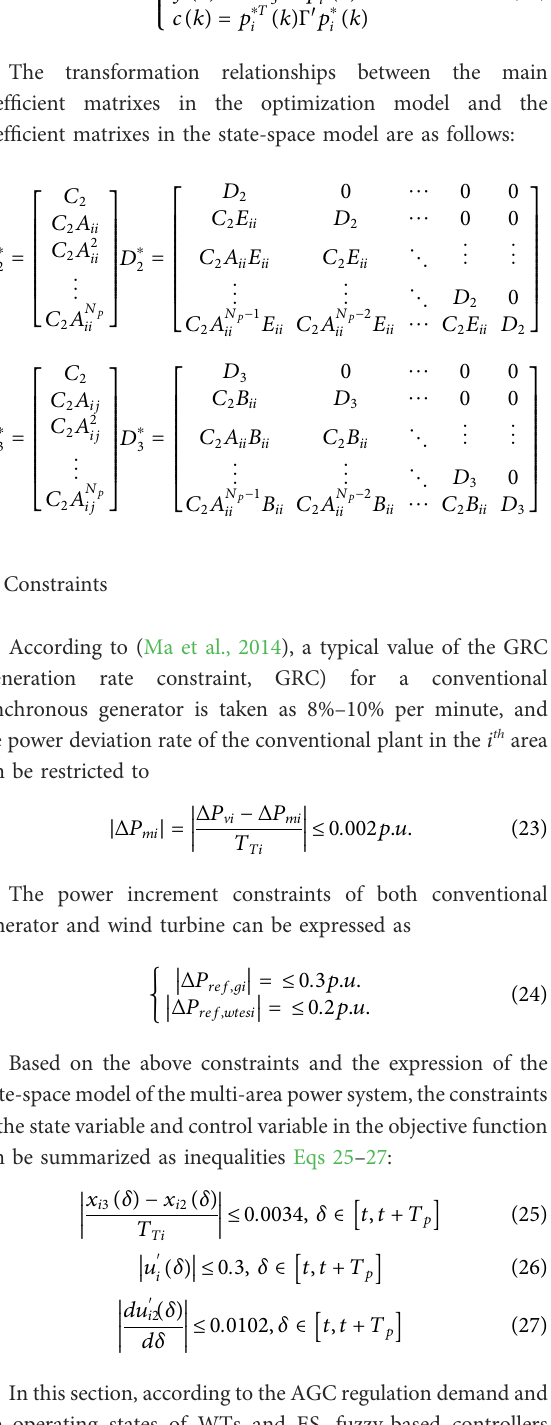
Figure 6. In FLC2, real-time wind speed data and state of charge (SOC) value are chosen as inputs of FLC2 to represent current operation states of CWES.